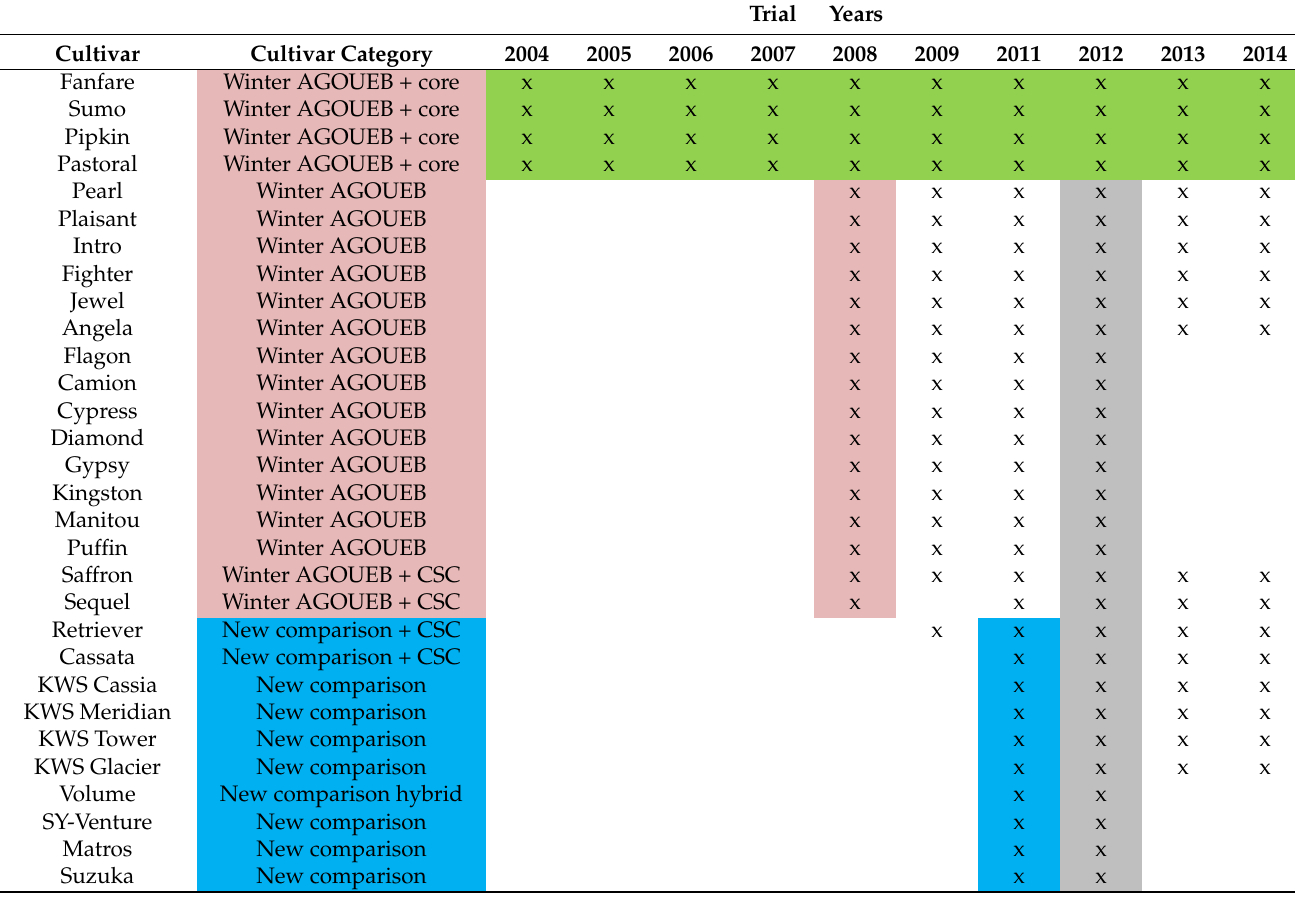
Table 1. Winter barley cultivars in trials 2004–2009 and 2011–2014 showing comparison groups. “Winter AGOUEB” indicates cultivars used in the ”Association Genetics of UK Elite Barleys BBSRC-Link project” (red shaded) (grant number RD-2004-3043). ”Core” is a set of 4 cultivars (green shaded) used across all trials. ”CSC” is the set of 4 cultivars used in the Centre for Sustainable Cropping, Balruddery in the first rotation cycle from 2011 to 2016. ”New comparison” (blue shaded) were cultivars sourced from UK Recommended List or breeders [12], some of which were trialled twice (grey